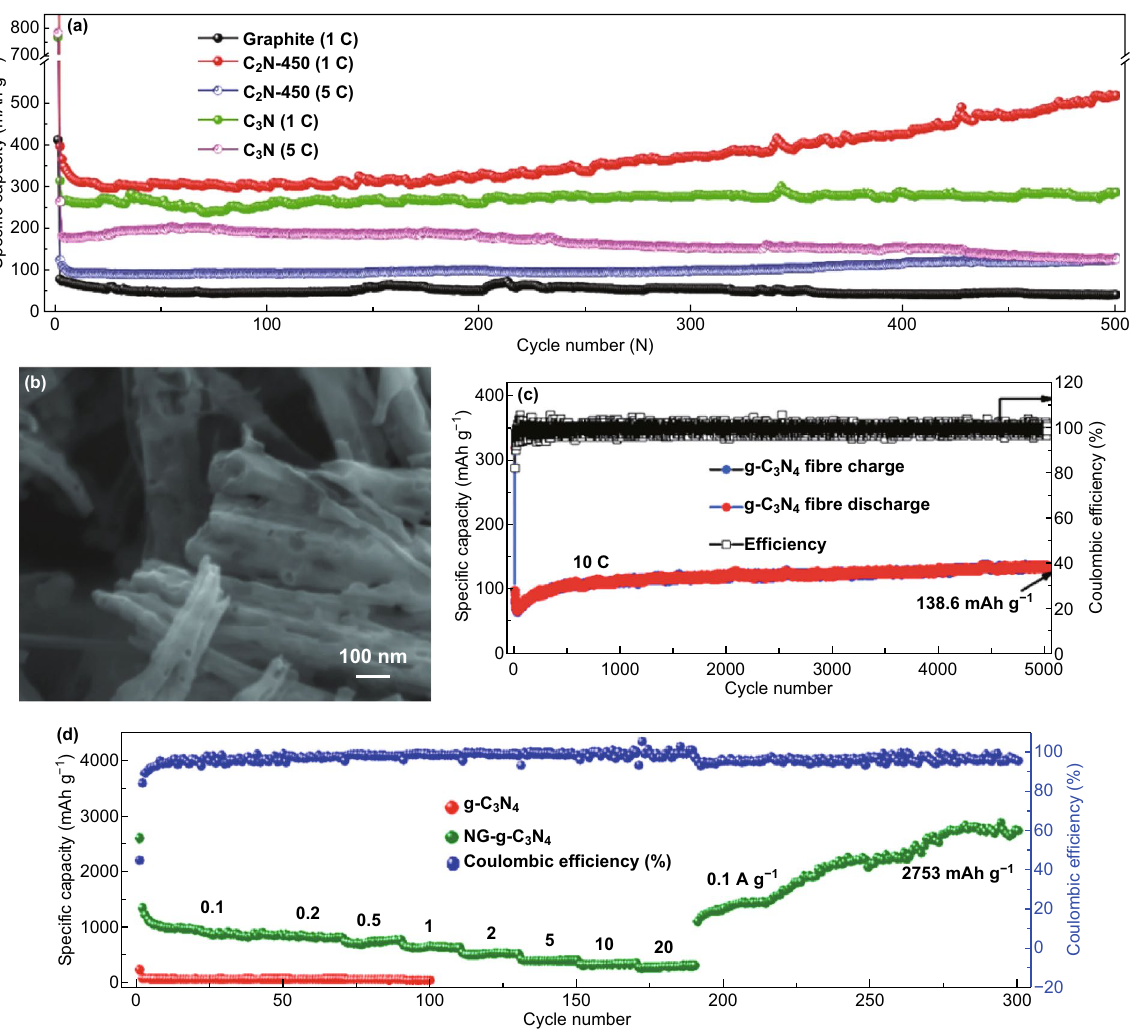
Fig. 17 a Long cycle life of C 2 N-450, C 3 N. Reproduced with permission from Ref. [50]. b SEM image of the 1D-g-C 3 N 4 fiber. c Cycling performance of 1D-g-C 3 N 4 fiber structure at a high current density of 10 C. Reproduced with permission from Ref. [46]. d Rate performance for ND-g-C 3 N 4 electrode at current density of 0.1, 0.2, 0.5, 1, 2, 5, 10, and 20 A g −1 and galvanostatic discharge property for g-C 3 N 4 electrode. Reproduced with permission from Ref. [8]. Copyright permissions from Wiley–VCH, and American Chemical Society. (Color figure